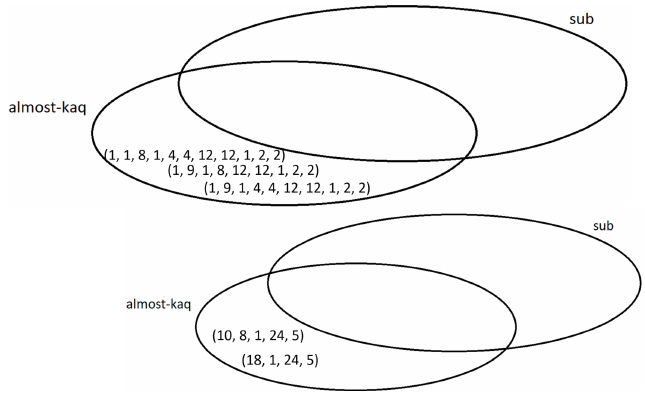
Figure 5 . su (7) : All almost- kaq patterns were non- sub .